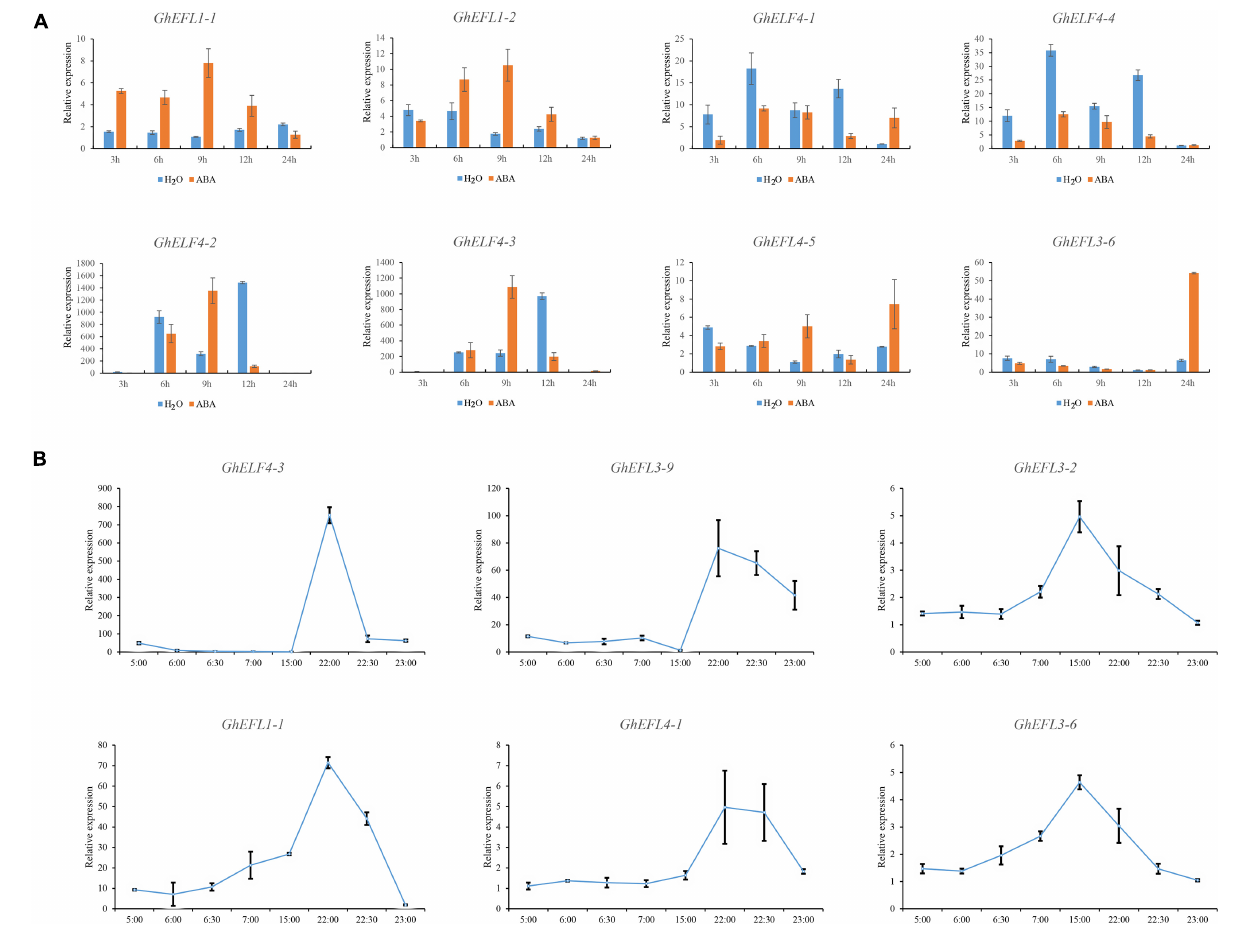
FIGURE 8 | Expression analysis of GhELF4s under ABA and light treatment via qRT-PCR. (A) Expression analysis of GhELF4s under ABA treatment via qRT-PCR. The TM-1 cotton seedlings were sprayed with water and 100 µ M ABA during the two-leaf flattening period, and cotton cotyledon samples were taken at 3, 6, 9, 12, and 24 h. Error bars show the standard deviation of three biological replicates. (B) qRT-PCR results of GhELF4s gene response to light at different times. Error bars show the standard deviation of three biological